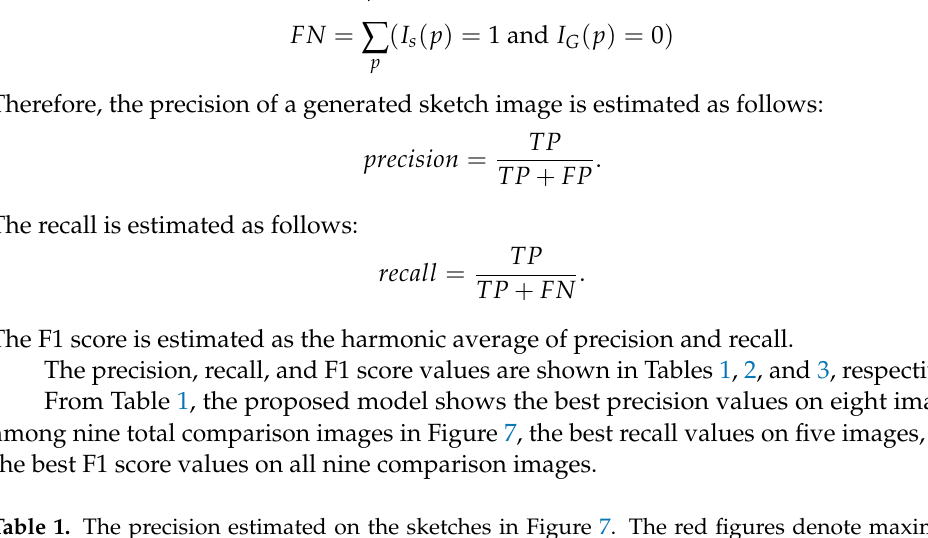
Table 1. The precision estimated on the sketches in Figure 7. The red figures denote maximum precision in each low.